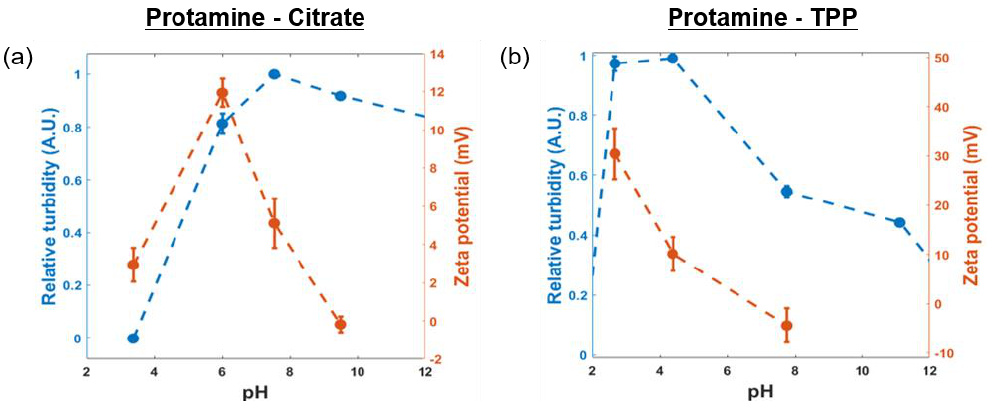
Figure 5. Effect of pH on complex coacervates of protamine and multivalent ions: pH-dependent turbidity and zeta potential measurements of the ( a ) protamine/citrate coacervate and ( b ) protamine/TPP coacervate.